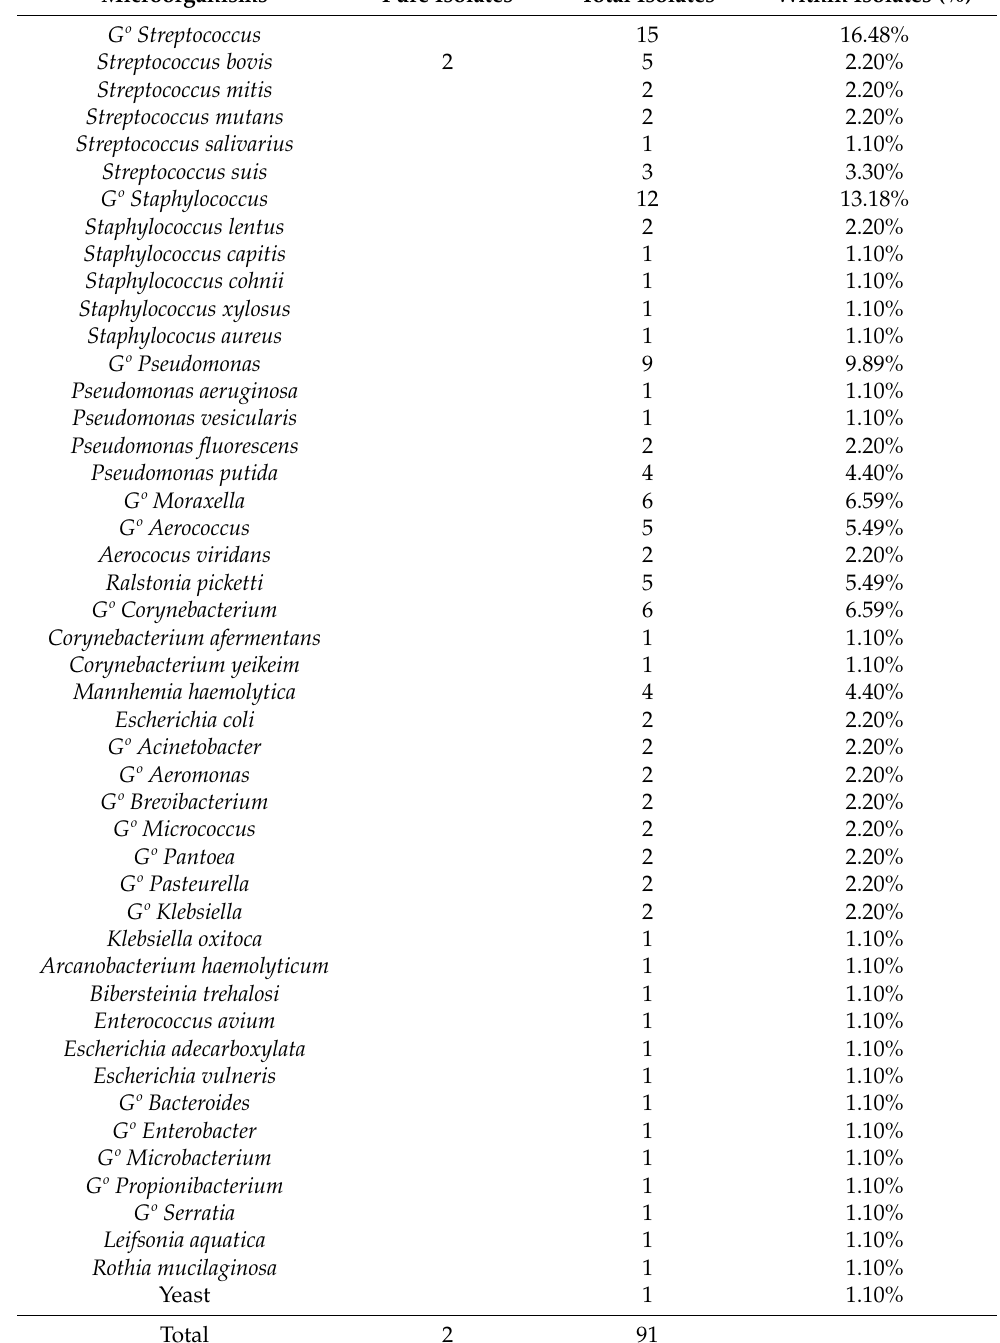
Table 2. Isolated microorganisms in oral samples of healthy sheep ordered by the total number of isolations (91) is shown. The total isolates of each microorganism and the isolation in pure culture is